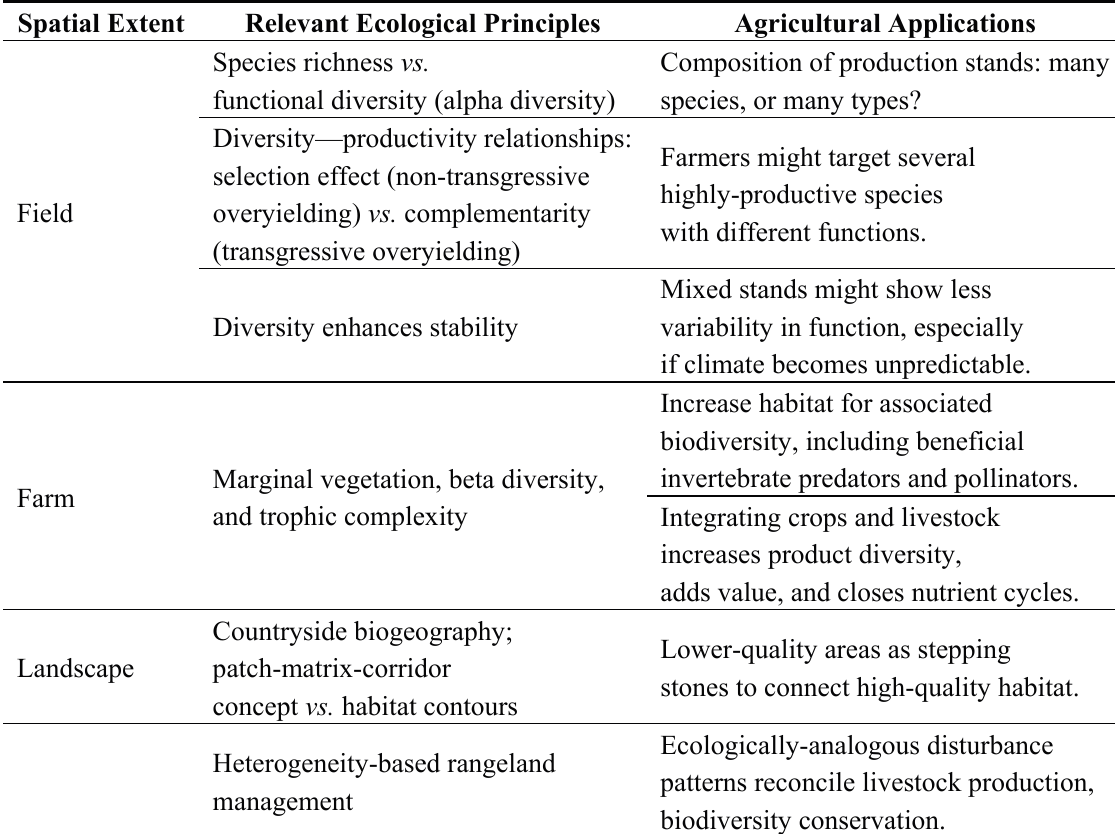
Table 1. Summary of ecological principles and their agricultural applications at each of the spatial extents considered in this